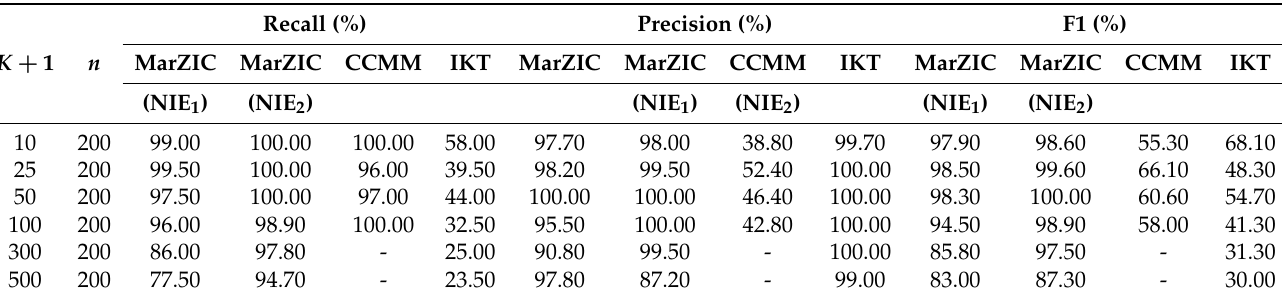
Table 2. Simulation results for the comparison of MarZIC with CCMM and IKT. Here n denotes the sample size and K + 1 denotes the number of taxa.